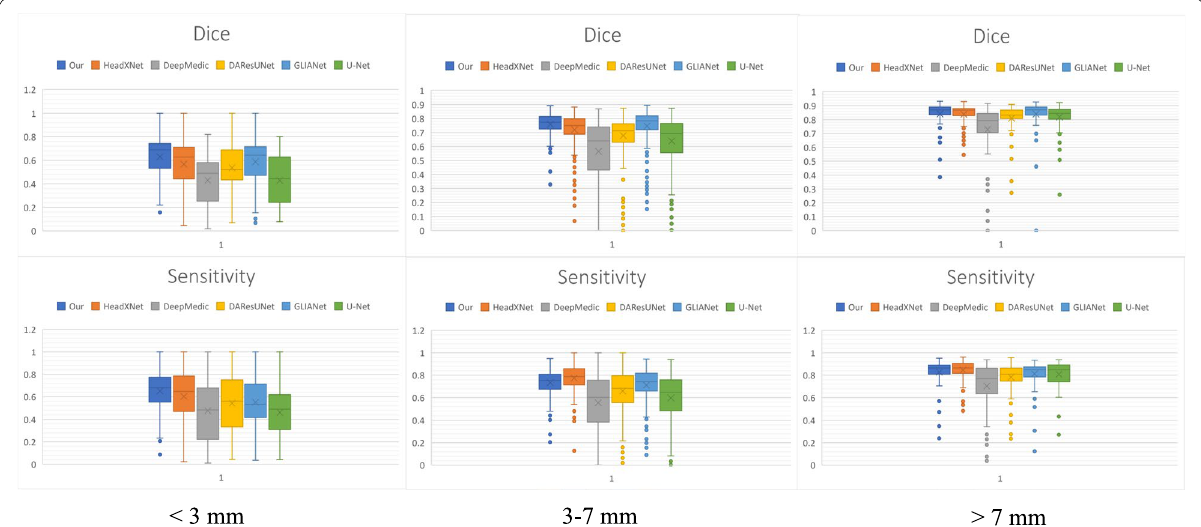
Fig. 9 Box plots of Dice metric values and sensitivities, for different models, with respect to segmenting images with three sizes of intracranial